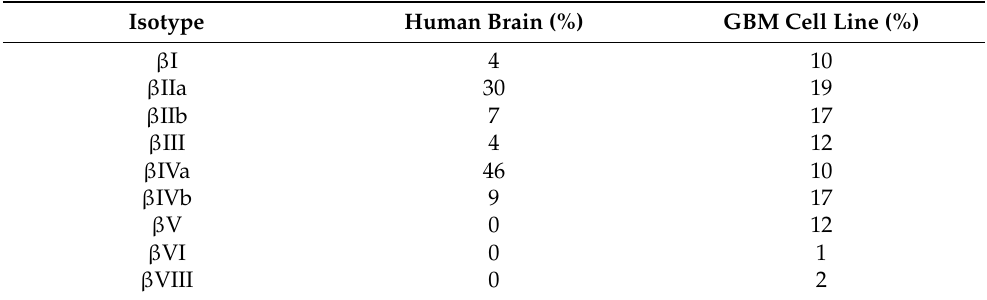
Table 4. Relative quantities of β tubulin isotypes in healthy human brain and glioblastoma multiforme cell